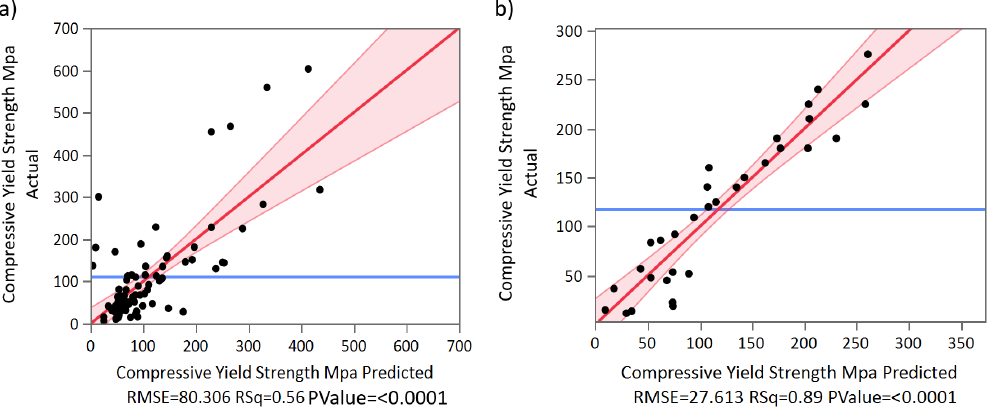
Figure 3. Distribution of the sample of 1000 values of Z T for SAC matrices generated with RC4 with Figure 16. Overall predicted model of compressive yield strength Actual versus compressive yield 32,64,128,160,256 . n = m ∈ { } strength Predicted of ( a ) beam-based sca ff olds, and ( b ) TPMS-based sca ff